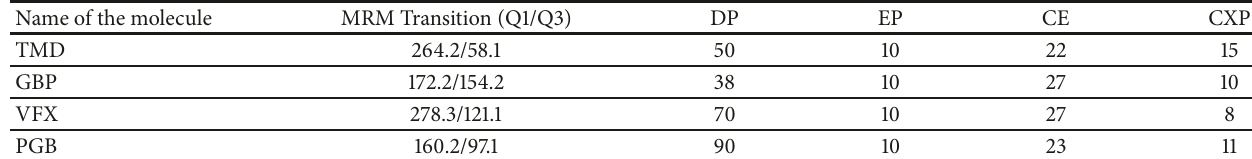
Table 1: MRM and mass spectrometer voltage details (TMD, GBP) and IS (VFX,